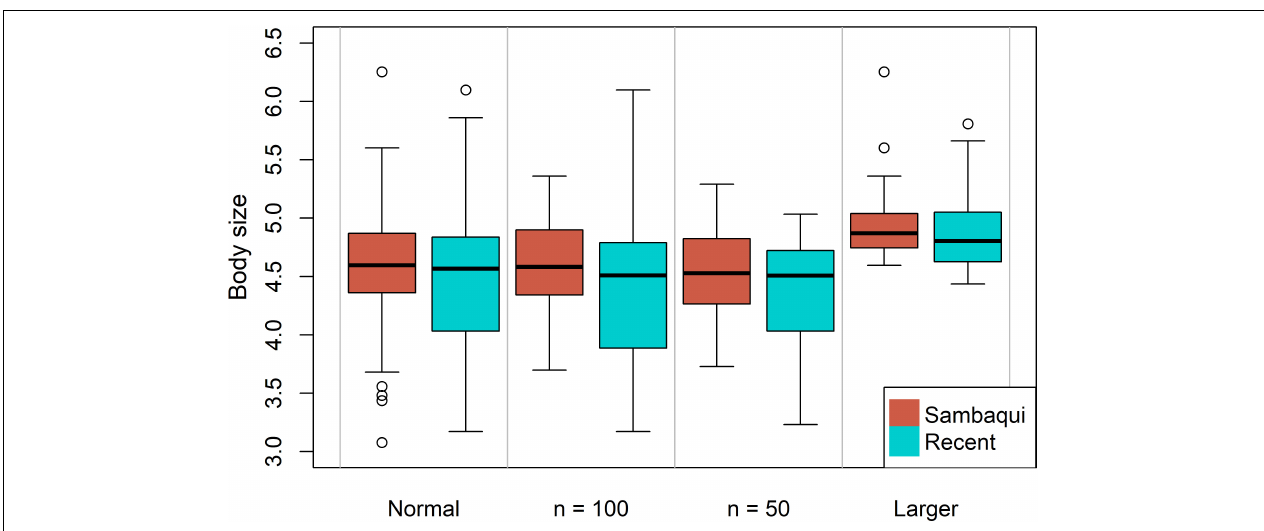
FIGURE 3 | Comparison between body sizes from all sambaquis and recent adult left valves ( n = 233, recent data were resampled), recent and ancient valves with n = 100 (both data were resampled), recent and sambaquis valves with n = 50 (both data were resampled), and recent and ancient valves larger than average ( n = 117, both data were resampled).